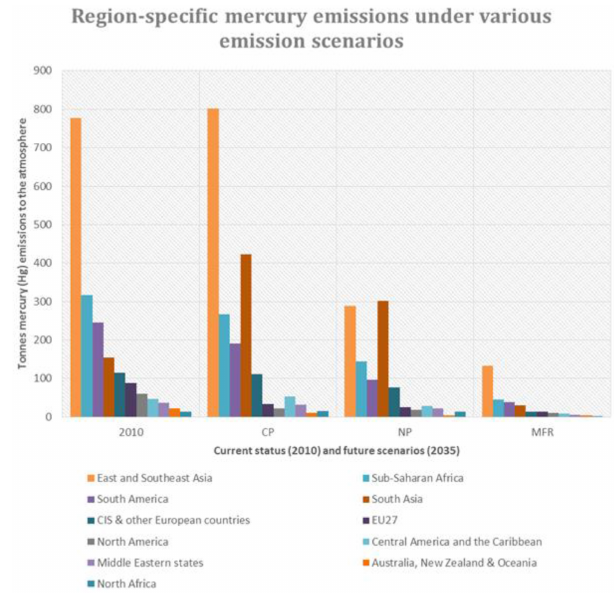
Figure 3. Region-specific emissions of mercury under various emission scenarios in